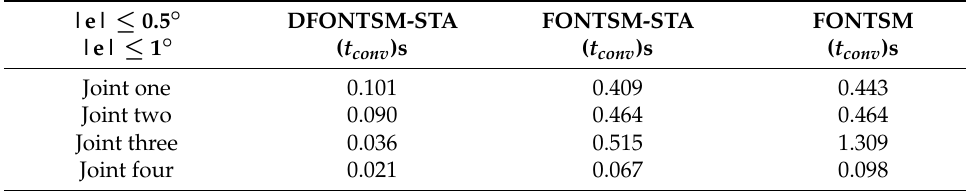
Table 7. Convergence time for each joint.